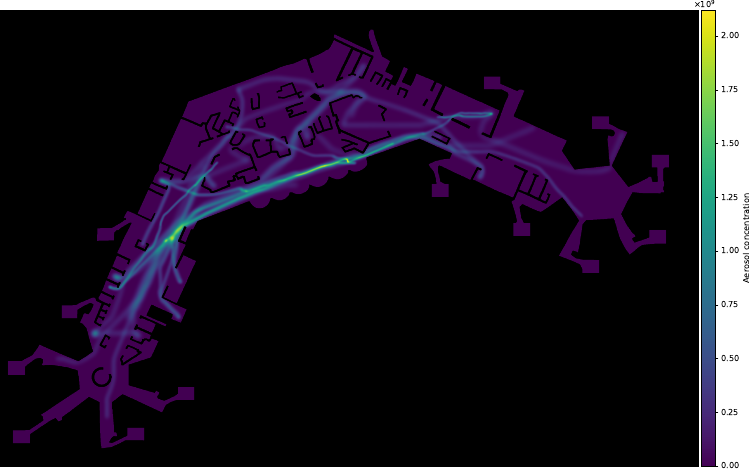
Figure 6. Exemplary visualisation of aerosol trails and corresponding amount of viral load.